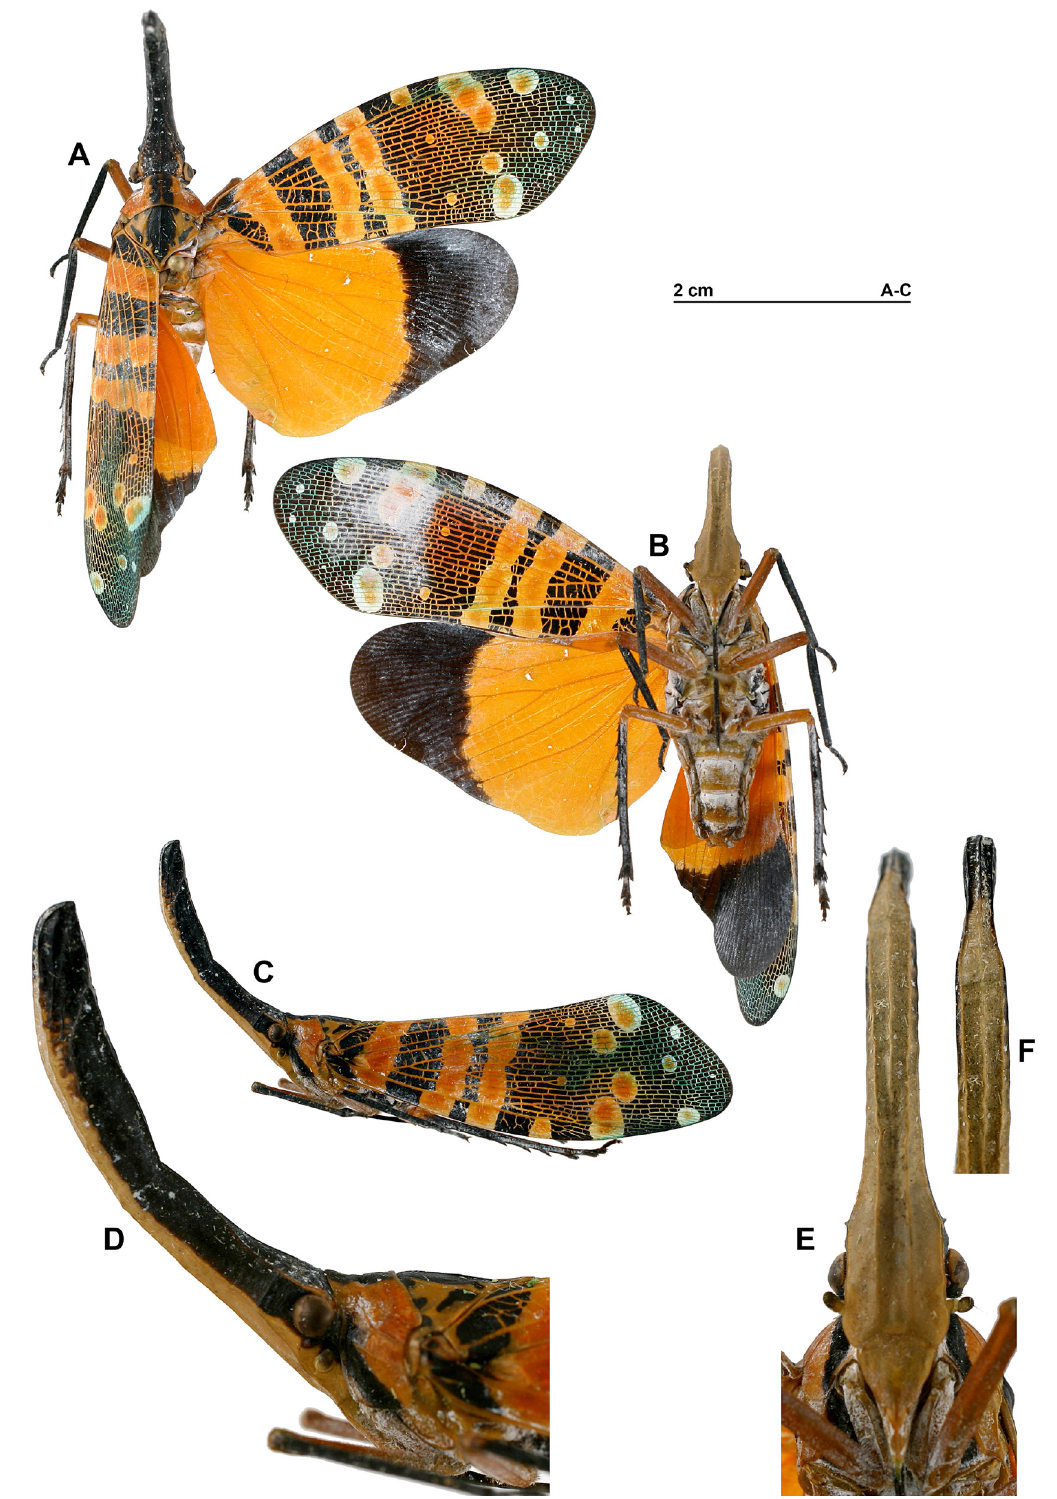
Fig. 15. Pyrops spinolae (Westwood, 1842), ♂, Vietnam, Vinh Phuc Prov., Me Linh Biodiversity Station, 20–24 Aug. 2010 (RBINS). A . Habitus, dorsal view. B . Habitus, ventral view. C . Habitus, lateral view. D . Head and thorax, lateral view. E . Head, perpendicular view of frons. F . Apex of cephalic process, anteroventral view. D–F = not to